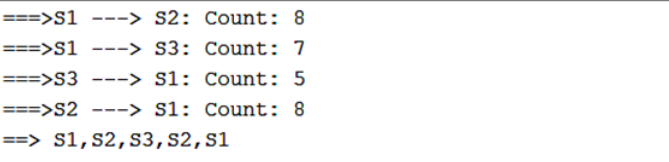
Figure 10. Algorithm 2 ’ s visualization of Path 1 vectors.